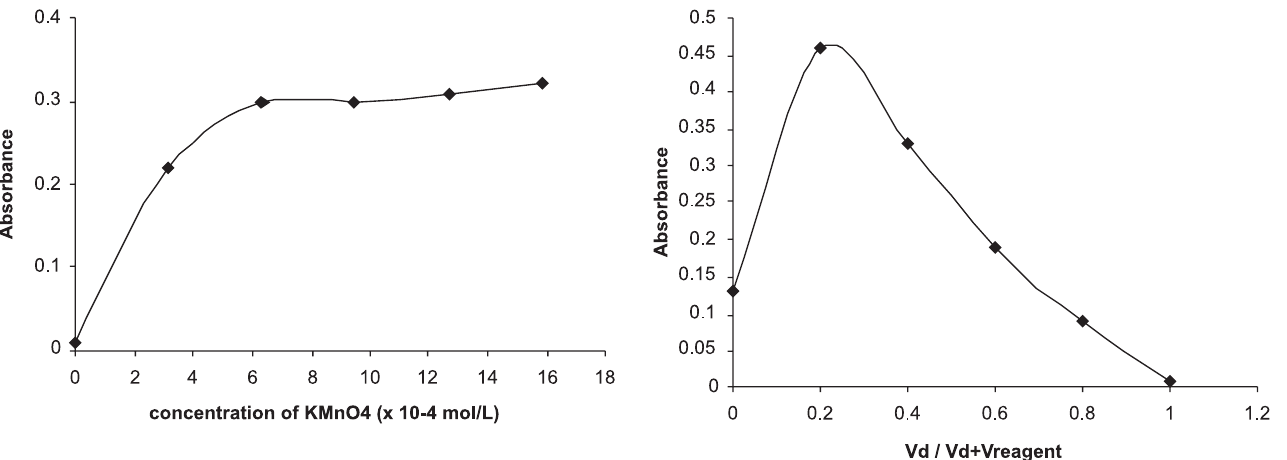
concentration for method B. 4